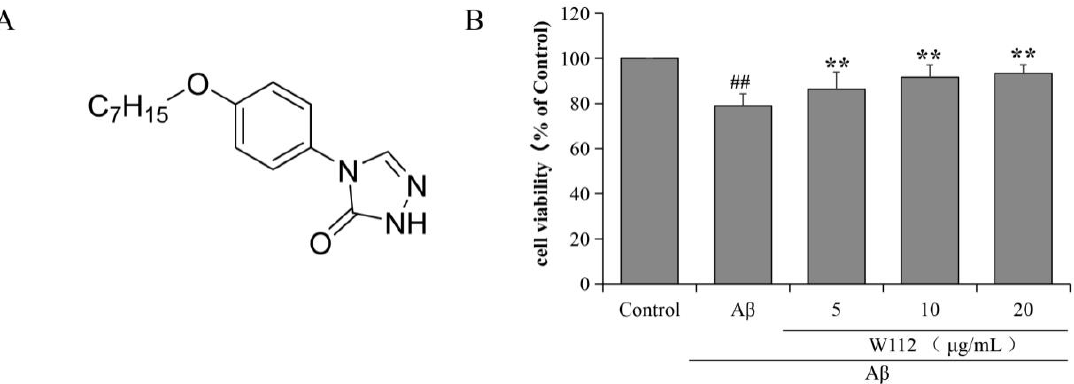
Figure 1. The chemical structure of W112 and the effect of W112 on the viability of PC12 cells induced by Aβ 25 – 35 . ( A ) Chemical structure of W112. ( B ) The MTT assay was used to detect the effect of W112 on PC12 cells activity. n = 6. ## p < 0.01 vs. the control group; ** p < 0.01 vs. the model group.